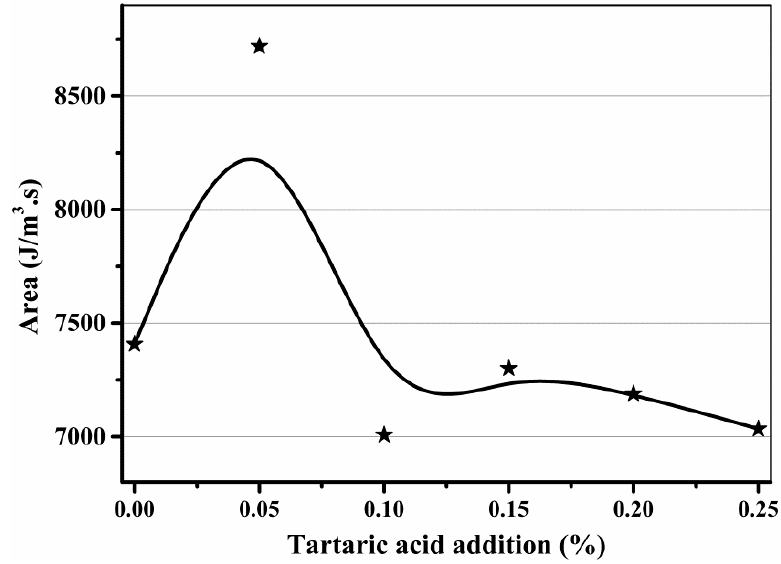
Figure 10. Thixotropy evaluation of the fresh SAC paste with different additions of TA from 0–0.25%.